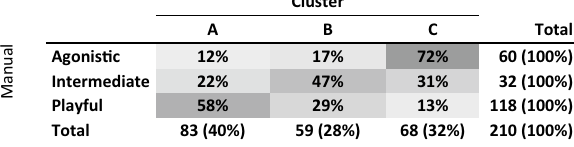
Table 5. Confusion matrix comparing manual expert-labels with those assigned by clustering algorithm.